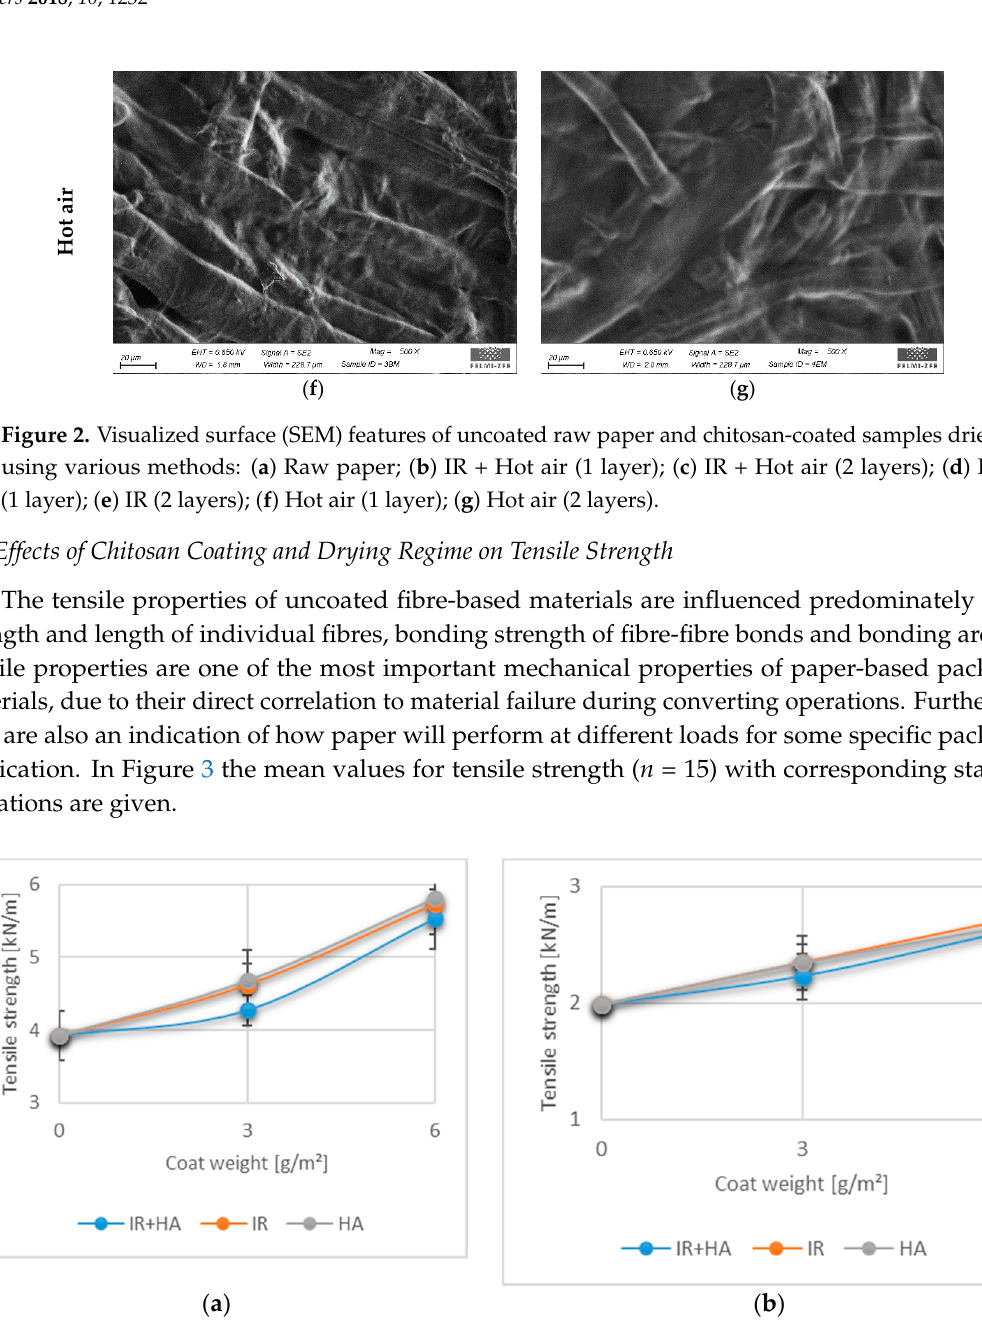
Figure 3. Tensile strength (TS) of paper coated with 3 g/m 2 (1 layer) and 6 g/m 2 (2 layers) of chitosan: ( a ) TI for machine direction (MD); ( b ) TI for cross direction (CD). ( n = 15).